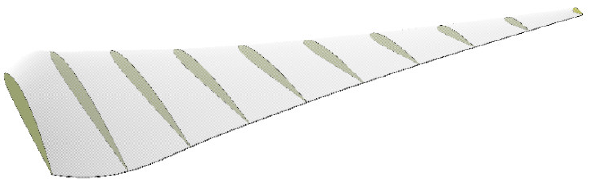
Figure 16. Selected comprehensive optimal VPP.